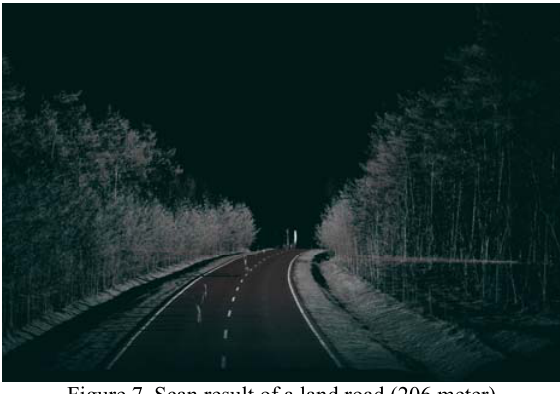
Figure 7. Scan result of a land road (206 meter)